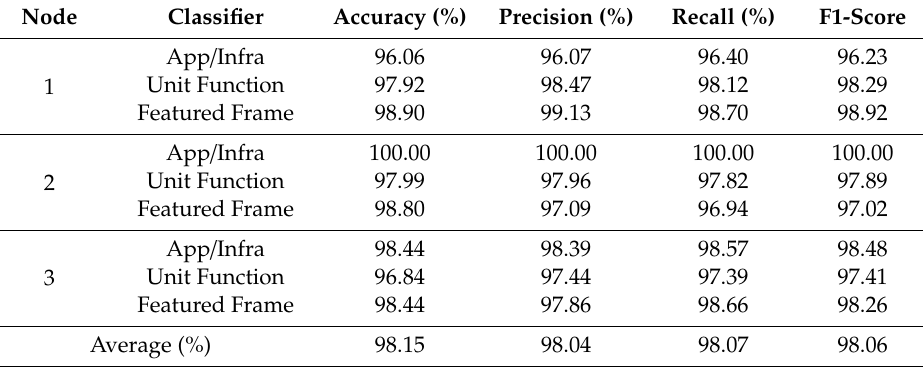
Table 3. Training results of the classifiers using a convolutional neural network